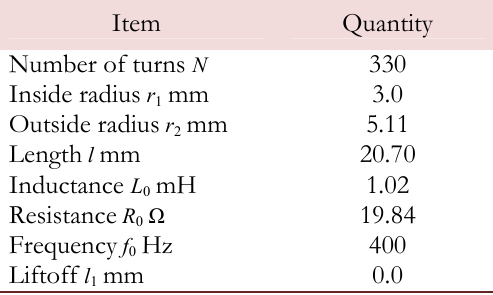
Table 3: Coil parameters.